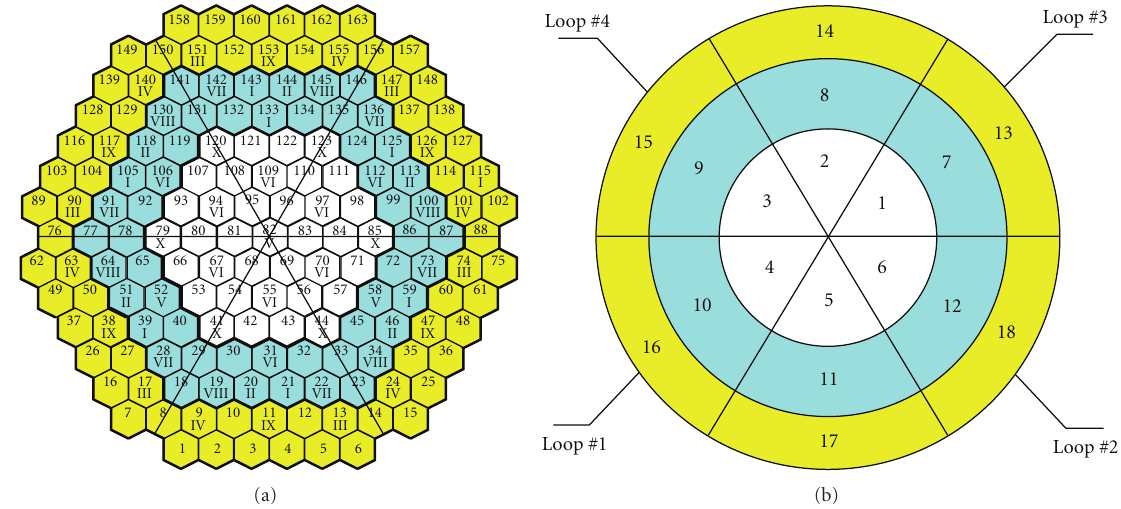
Figure 9: TRACE Nodalization of the core and relative position of the cold/hot legs.